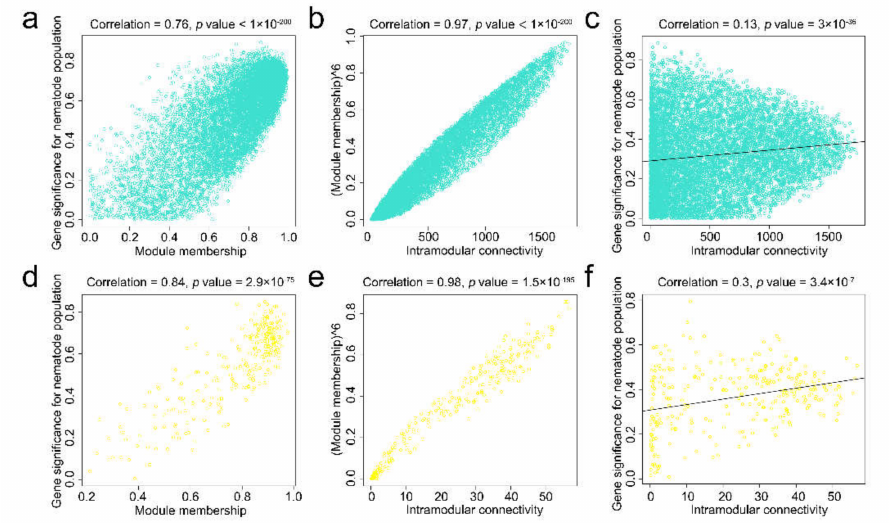
Figure 5. Relationship between gene significance (GS), module membership (MM), and intramodular connectivity (IC). ( a ) GS for the nematode population (y-axis) vs. MM (x-axis) for the turquoise module; ( b ) MM raised to power 6 (y-axis) vs. IC (x-axis) for the turquoise module; ( c ) GS (y-axis) vs. IC (x-axis) for the turquoise module; ( d ) GS for the nematode population vs. MM for the yellow module; ( e ) MM raised to power 6 vs. IC for the yellow module; ( f ) GS vs. IC for the yellow